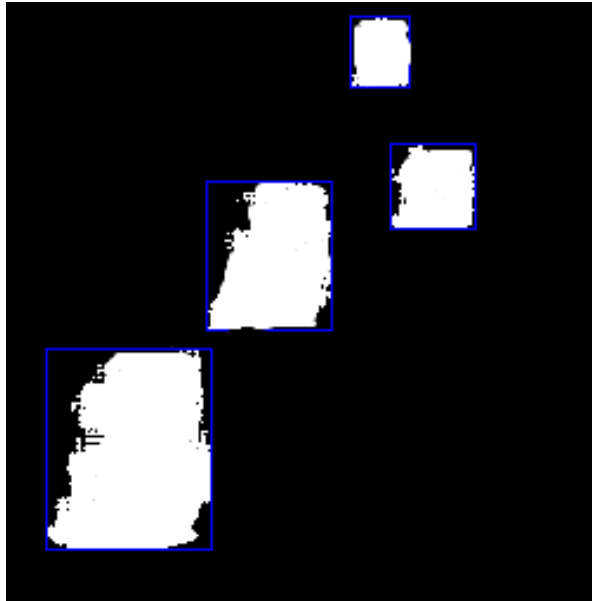
Figure 2. Regions of